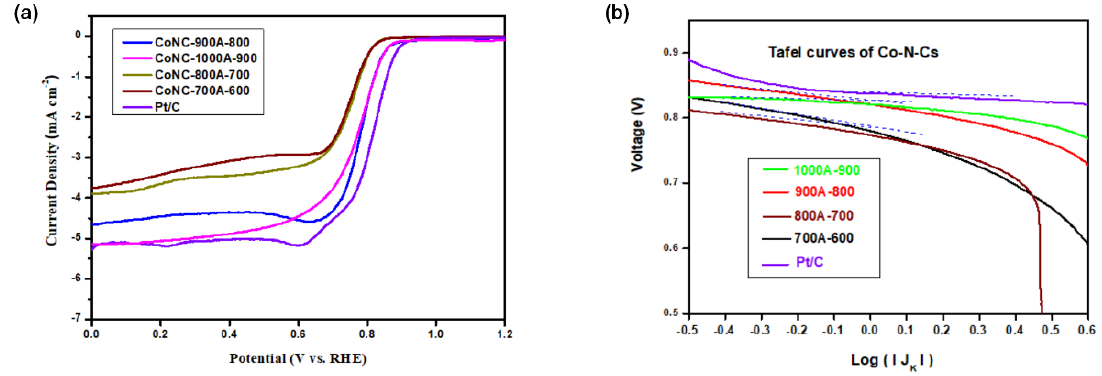
Figure 9. ( a ) LSV curves of Co-N-Cs treated with two-stage calcinations and Pt/C catalysts; ( b ) Tafel curves obtained from J k of LSV curves . Table 4. Comparison of various electrochemical properties of Co-N-C catalysts.